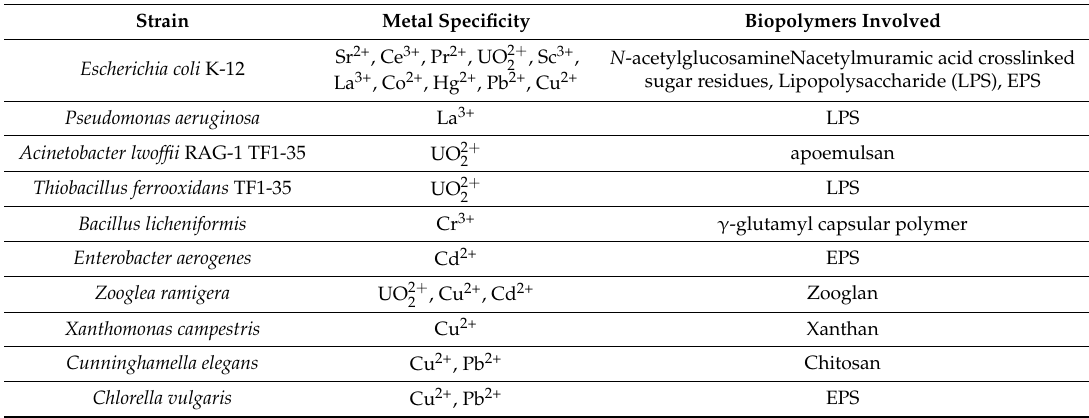
Table 1. Specificity of bacterial polysaccharides for metals. Strain Metal